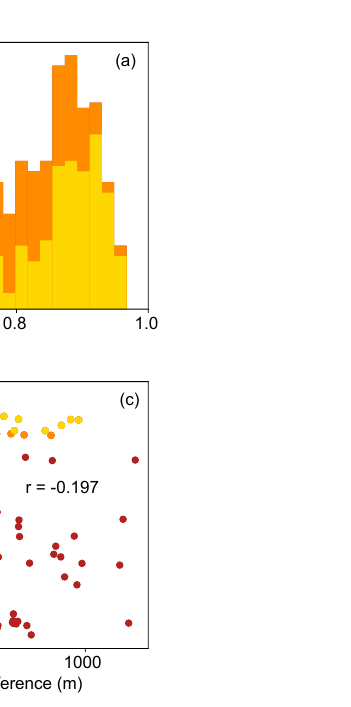
Figure 2. (a) Histogram of R 2 of all nonfiltered sites (dark red), R 2 -filtered sites (orange), and r -filtered sites (yellow); (b) scatterplot of the R 2 and the horizontal distance between the closest MERRA-2 grid cell and the actual locations of the sites using the same color scheme in (a) ; (c) scatterplot of the R 2 and the elevation difference between the closest MERRA-2 grid cell and the actual locations of the wind sites using the same color scheme in (a) . The r in (b) and (c) represents the Pearson’s r using all nonfiltered